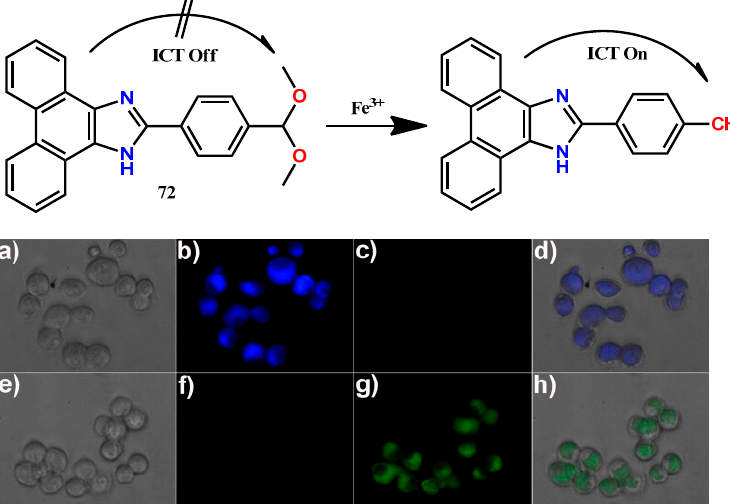
Figure 9. The design concept of fluorescent ratiometric probe 72 for Fe 3+ . Fluorescence and bright-field images of pancreatic cancer cells. ( a ) Brightfield image of the cells stained with probe 72 (1 μ M) for 30 min; ( b ) fluorescence image of ( a ) with emission at 445 ± 10 nm; ( c ) fluorescence image of ( a ) with emission at 530 ± 10 nm; ( d ) an overlay image of ( a )–( c ); ( e ) bright-field image of cells pretreated with Fe 3+ (50 μ M) for 30 min and then further incubated with probe 72 (1 μ M) for 30 min; ( f ) fluorescence image of ( e ) with emission at 445 ± 10 nm; ( g ) fluorescence image of ( e ) with emission at 530 ± 10 nm; ( h ) an overlay image of ( e )–( g ) (Reproduced from Ref. [81] with permission from Elsevier).